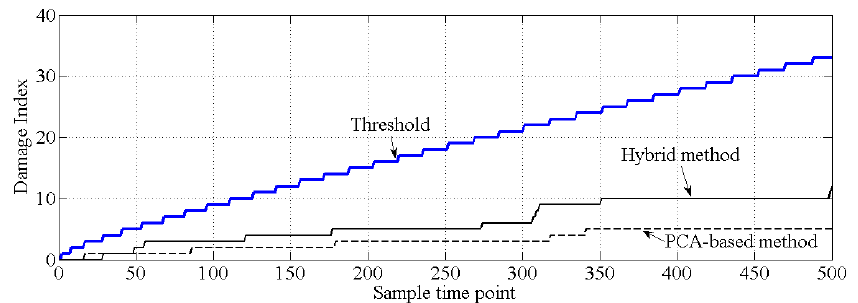
Figure 19. Results of damage detection for an actual bridge.